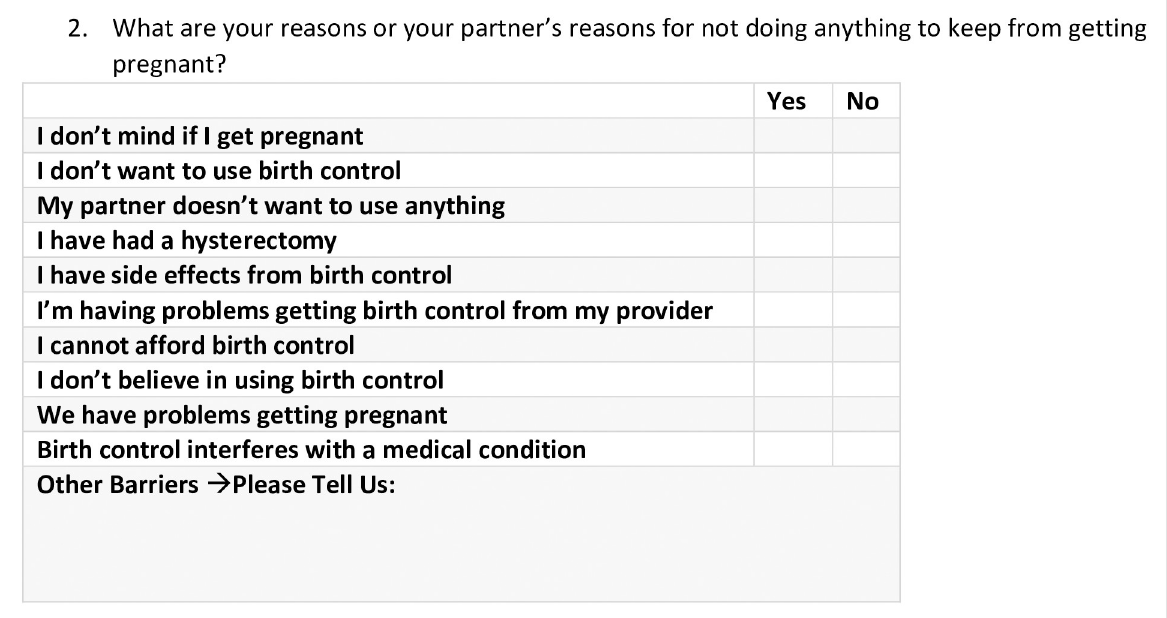
PLOS Medicine| https://doi.org/10.1371/journal.pmed.1003878 January 5,